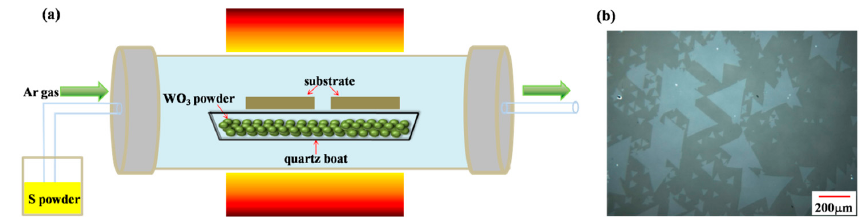
Figure 1. ( a ) Schematic diagram of CVD growth system; ( b ) optical image of WS 2 .